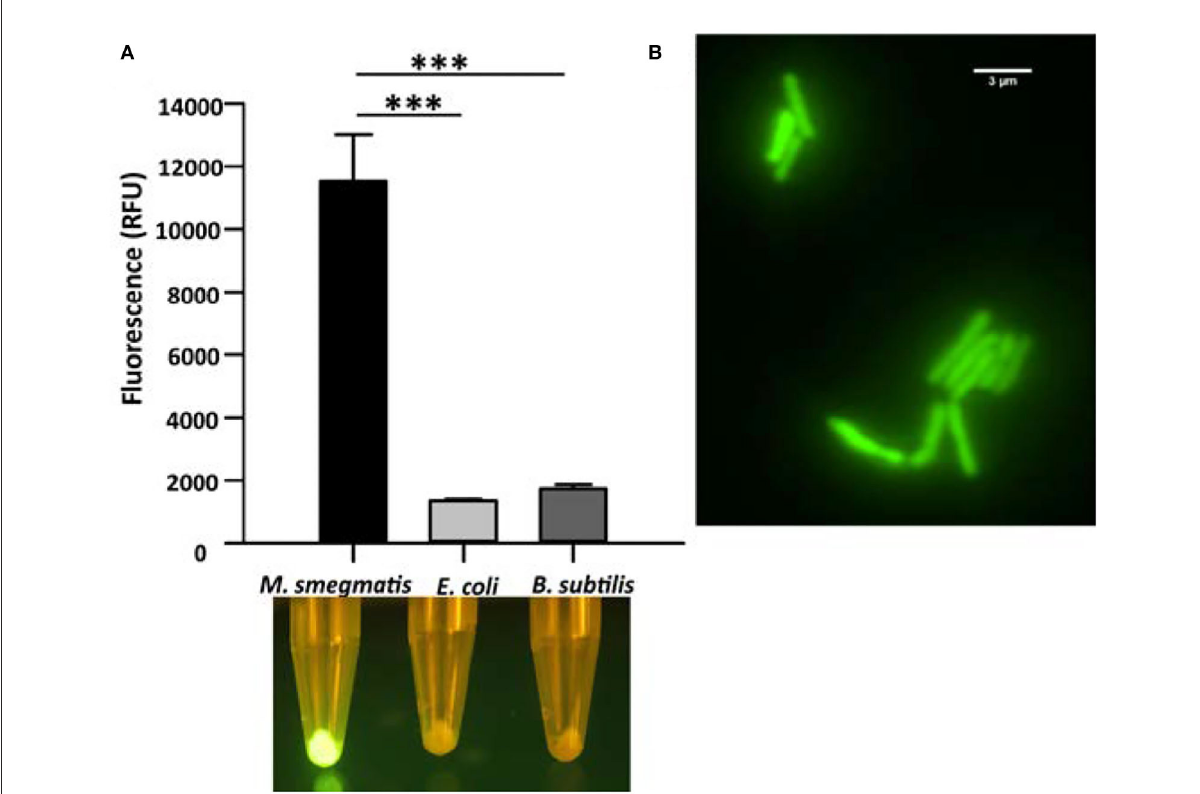
FIGURE1 Cell binding assay of CTD-GFP with different bacterial cells. (A) The relative fluorescence obtained for CTD-GFP bound to M. smegmatis , E. coli , and B. subtilis cells. Fluorescence was measured by keeping the excitation and emission wavelengths at 488 and 509nm, respectively. The data represent an average of three experiments with error bars denoting the standard deviation ( p -value analysis: *** , < 0.0003). The bottom panel shows the image of fluorescing cell pellet obtained after illuminating it with a blue light ( ∼ 470nm) source. (B) Fluorescence microscopy imaging of CTD-GFP bound M. smegmatis cells. The image was taken on a Leica Microsystems fluorescence microscope with a GFP